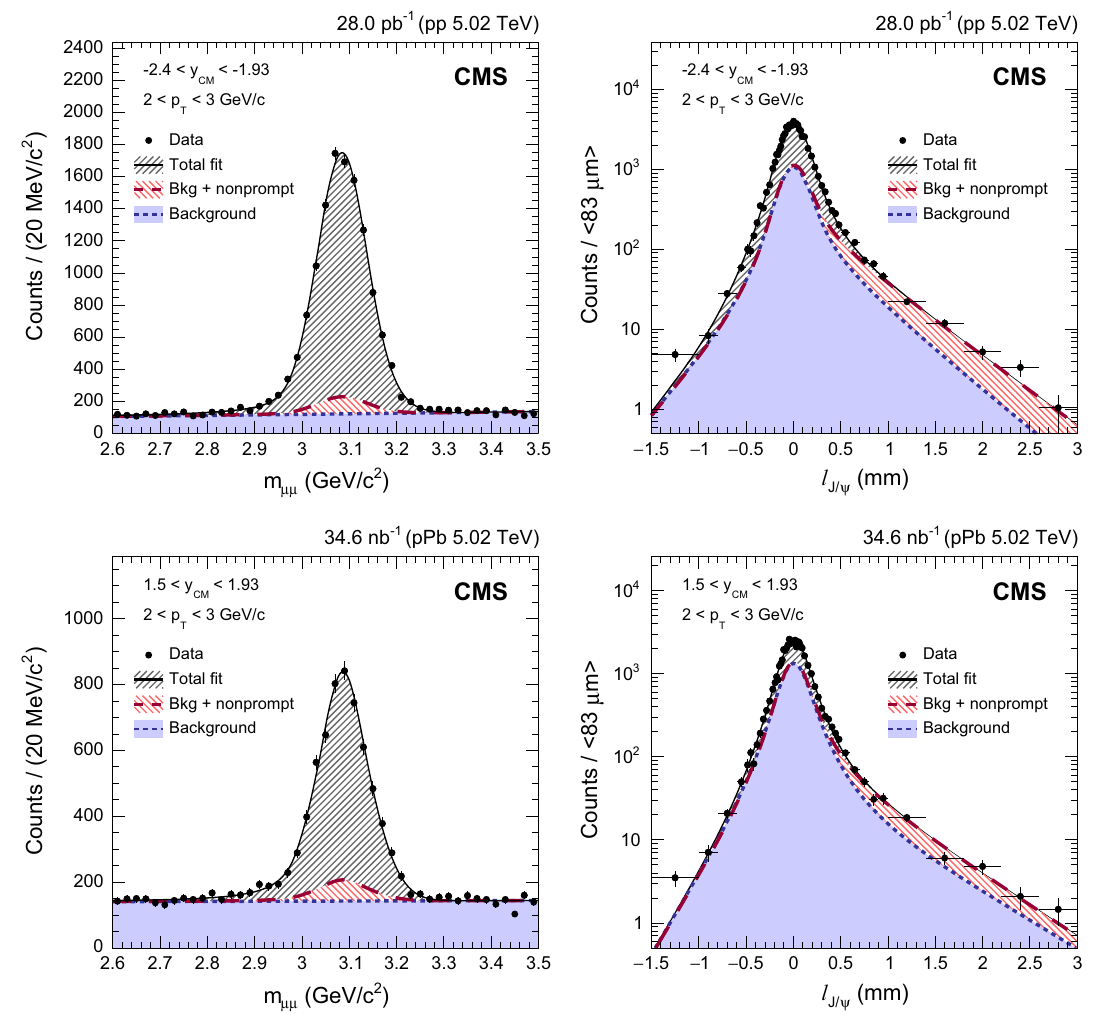
Fig. 1 Examples of the invariant mass ( left ) and pseudo-proper decay length ( right ) distributions of μ + μ − pairs for pp ( upper ) and pPb ( lower ) collisions. The bin widths of (cid:7) J /ψ distributions vary from 15 to 500 µ m, with the averaged value of 83 µ m. The projections of the 2D fit